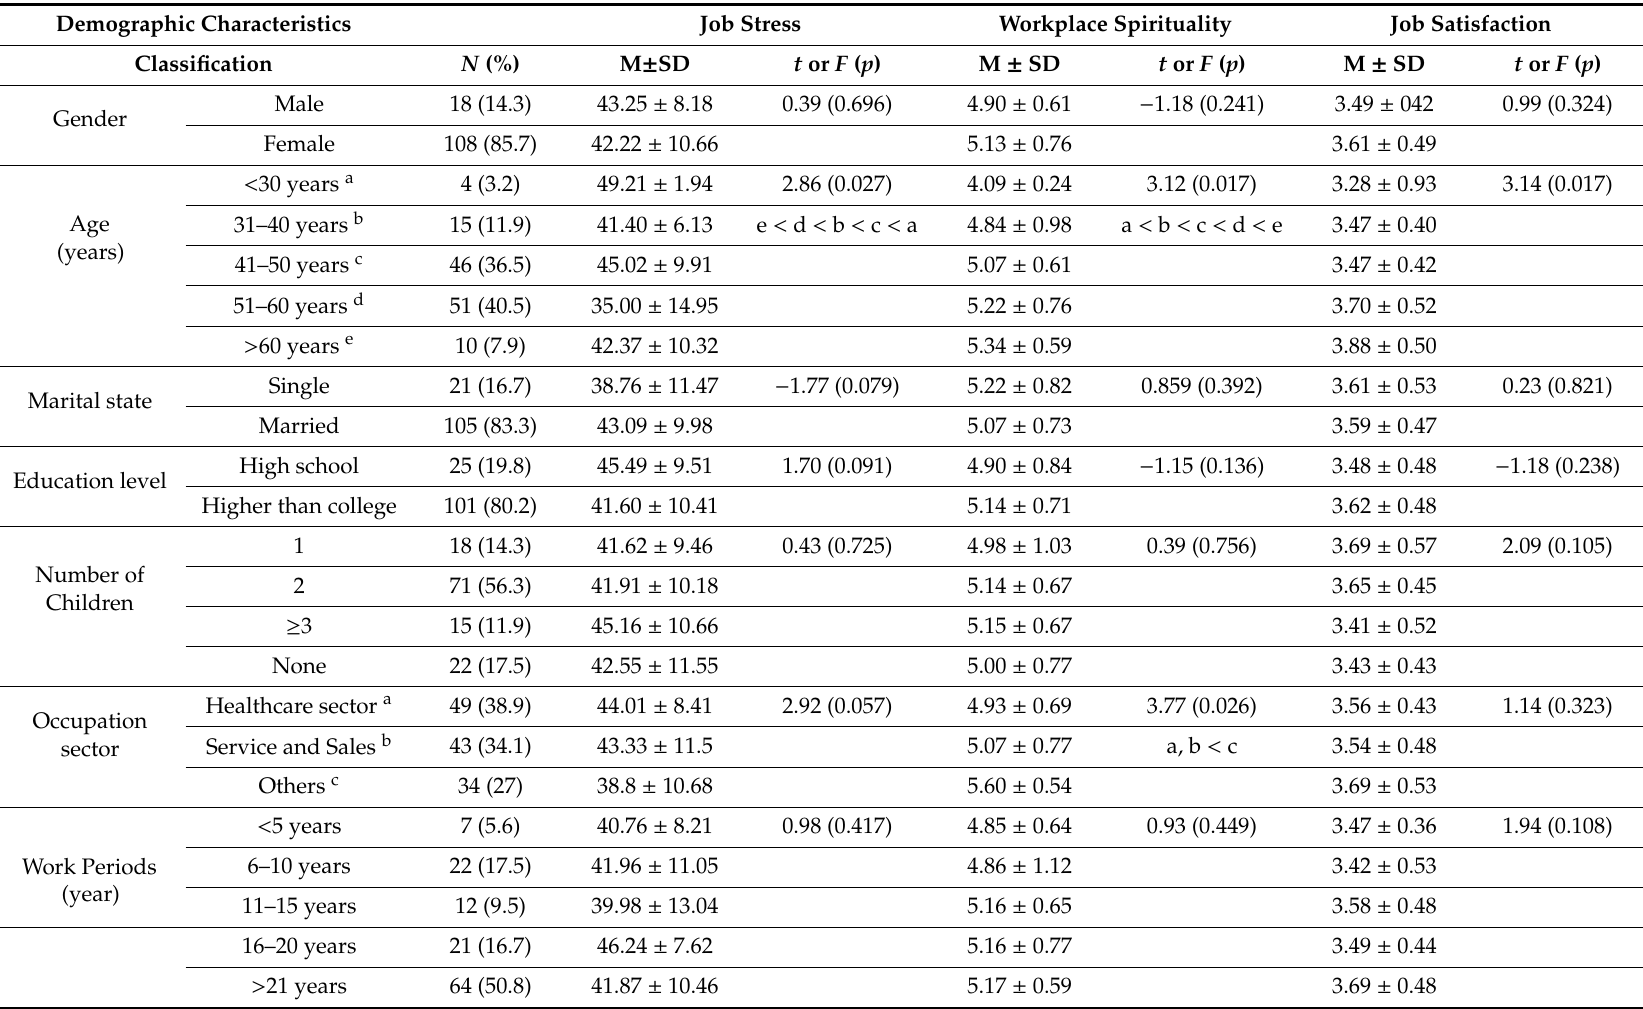
Table 1. General characteristics of participants and di ff erences in job stress, workplace spirituality, and job satisfaction ( N = 126). Demographic